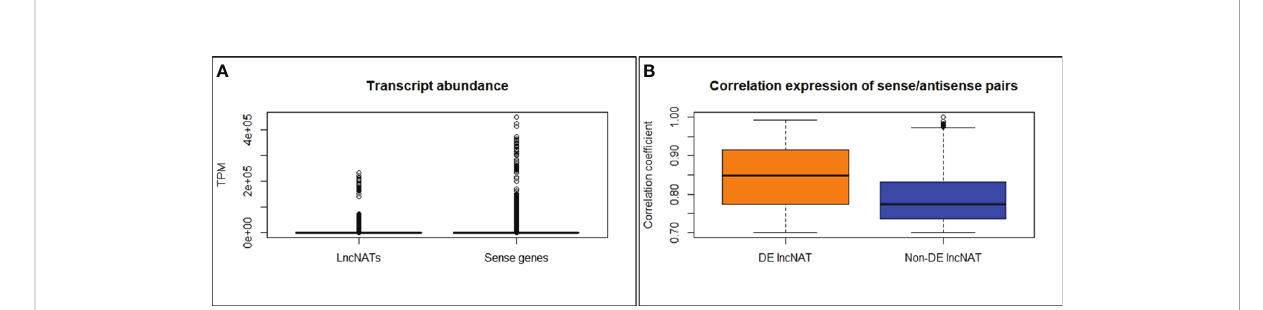
FIGURE 4 LncNATs are less abundant than their sense counterparts (A) . DE lncNATs exhibited a higher expression correlation with their sense protein- coding genes than non-DE lncNATs (B)